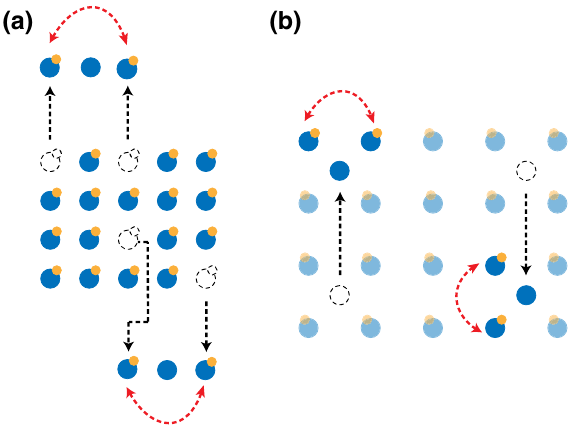
FIG. 5. Two possible extensions of the molecule-Rydberg gate to larger arrays. (a) Using optical tweezers, molecules can be transported to positions next to atoms. At these locations, the gate scheme can proceed without involving other molecules. If atoms are placed far enough away, multiple gates can proceed in par- allel. (b) Movable atoms can be placed sparsely throughout the array to mediate interactions between molecules of interest. The molecules that should not interact are placed in other rotational states that are off resonant with the Rydberg atom transition.